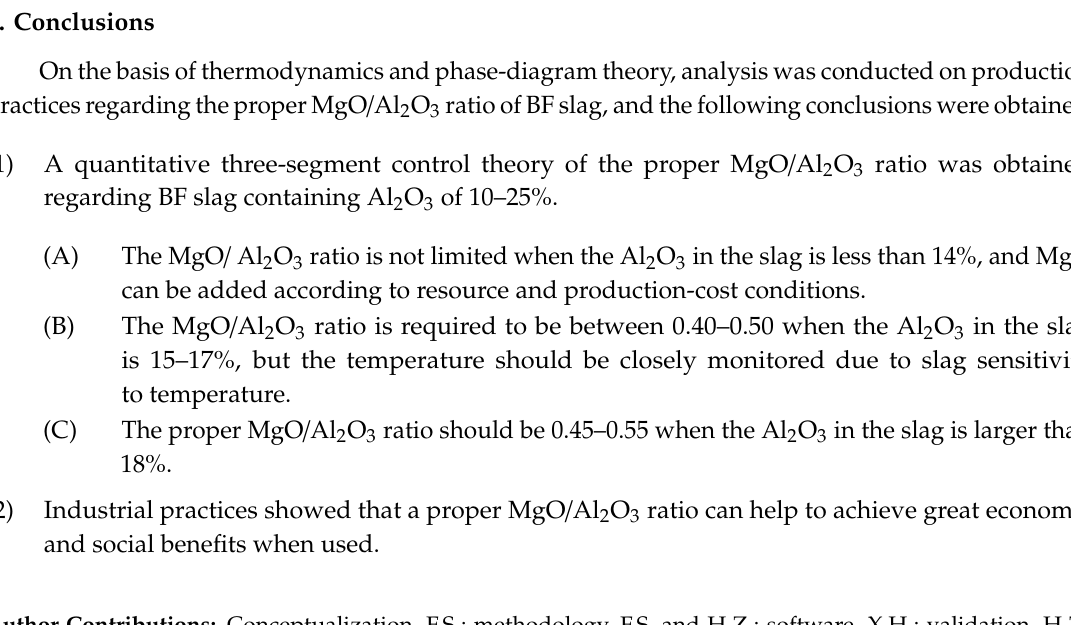
Table 4. Technological production data of MgO and Al 2 O 3 for a steel company in recent years. Sinter BF Slag Year MgO, % Al 2 O 3 , % MgO, % Al 2 O 3 , % MgO / Al 2 O 3 2013 1.80 1.81 7.96 15.50 0.51 2014 1.79 1.85 7.70 15.65 0.49 2015 1.64 1.87 7.26 15.73 0.46 2016 1.62 1.82 7.06 16.32 0.43 2017 1.50 1.79 7.02 16.17